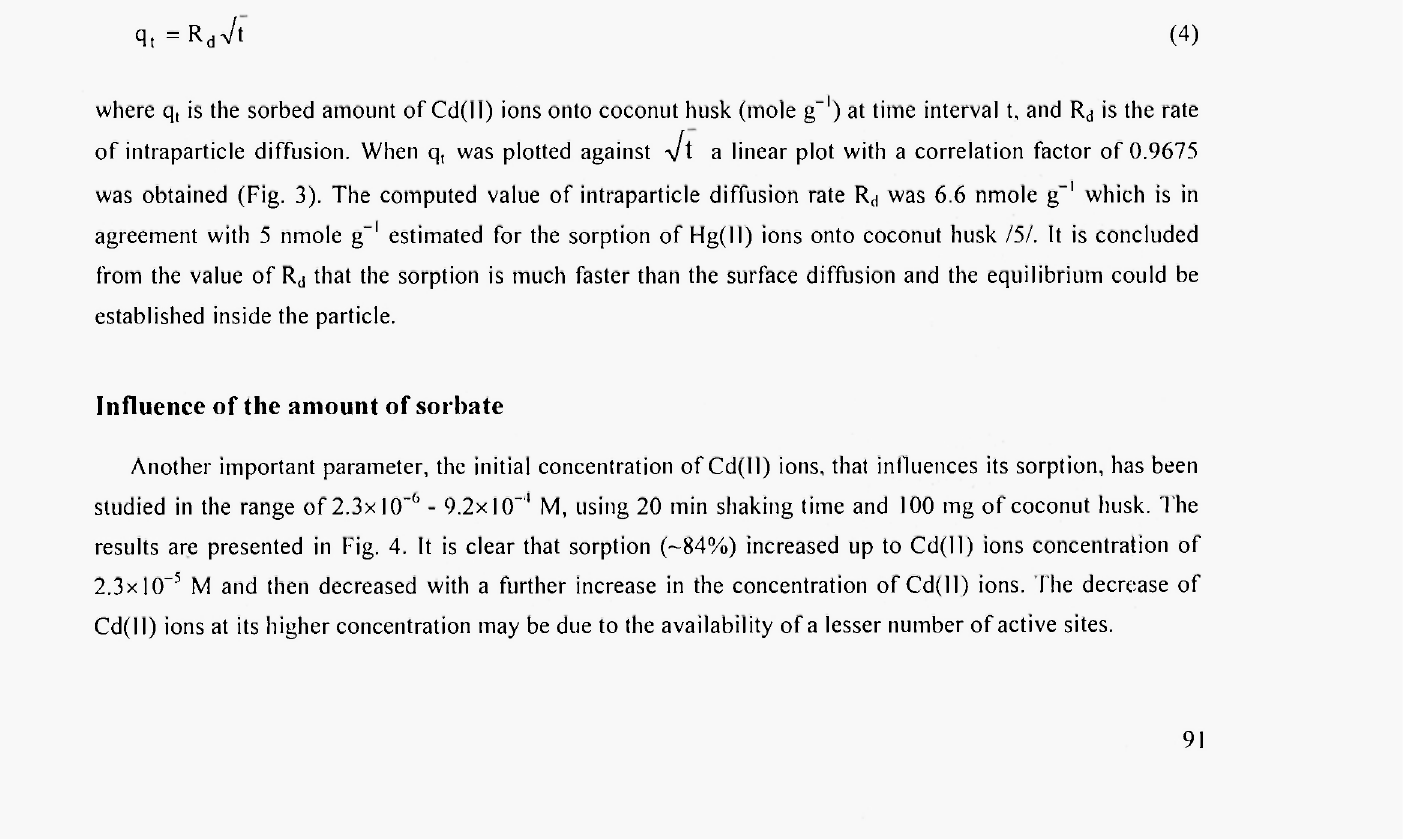
Fig. 2: Influence of the amount of sorbent on the sorption of Cd(ll) ions (2.29 χ 10 5 Μ) onto coconut husk.